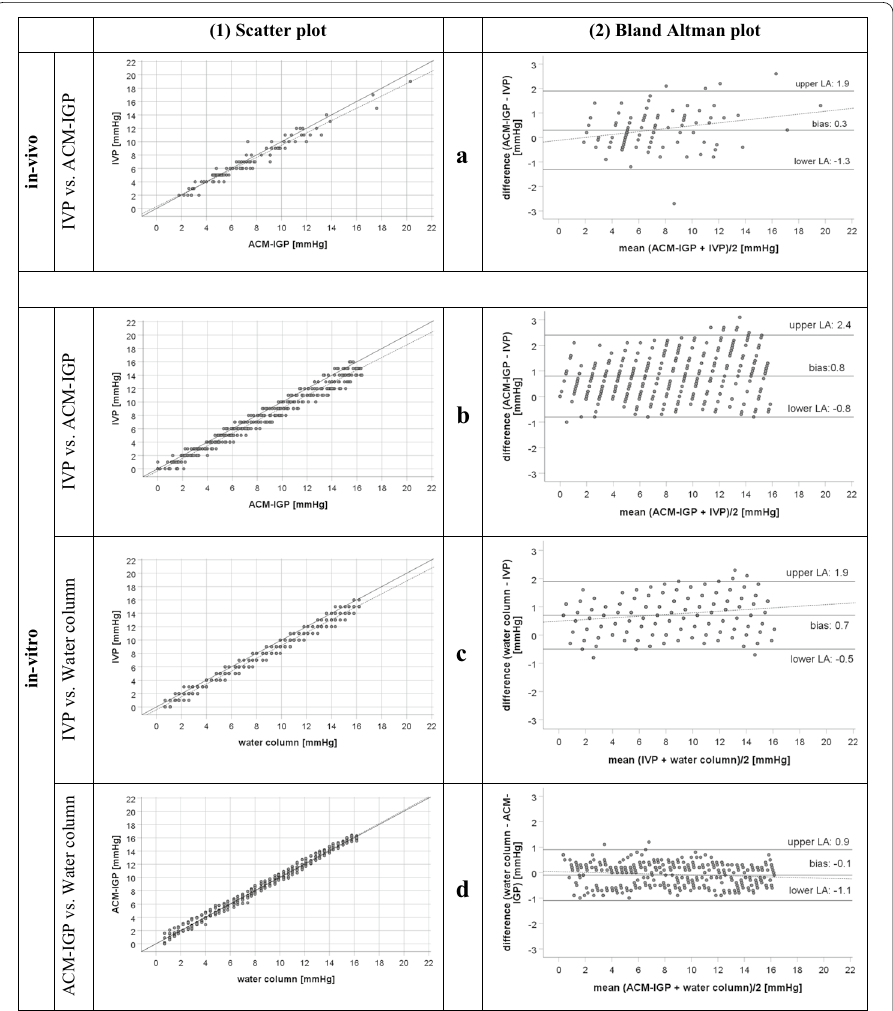
Fig. 2 In vivo and in vitro measurements. Presentation of measurement agreement between IVP and ACM-IGP measurements in vivo ( a ) and in vitro ( b – d ). a Scatter plot and Bland–Altman plot of in vivo measurements. a1 Scatter plot of paired IAP measurements obtained by novel ACM-IGP and IVP (reference method) with the solid line representing linear regression and the dashed line representing the line of identity. a2 Bland–Altman plot of IVP and ACM-IGP. Mean bias precision between IVP and ACM-IGP was ± 0.3 0.8 mmHg; limits of agreement (LOA) were 1.3 to 1.9 mmHg. The dashed line represents the best-fit ± − straight line, which increases slightly with rising IAP. b – d Scatter plots and Bland–Altman plots of in vitro measurements in a container model. In all scatter plots the solid line is representing linear regression and the dashed line the line of identity. b1 Scatter plot of paired pressure measurements obtained by IVP and ACM-IGP. b2 Bland–Altman plot: Mean bias precision was 0.8 0.8 mmHg; LOA were 0.8 to 2.4 mmHg. ± ± − The dashed line represents the best-fit straight line, which is parallel to mean bias. c1 Scatter plot of paired pressure measurements obtained by IVP and water column (gold standard). c2 Bland–Altman plot: Mean bias precision was 0.7 0.6 mmHg; LOA were 0.5 to 1.9 mmHg. The dashed best-fit straight line increases ± ± − slightly with rising pressures. d1 Scatter plot of paired pressure measurements obtained by ACM-IGP and water column. d2 Bland–Altman plot: Mean bias precision was 0.1 0.5 mmHg; LOA were 1.1 to ± − ± − 0.9 mmHg. The dashed best-fit straight line increases slightly with rising